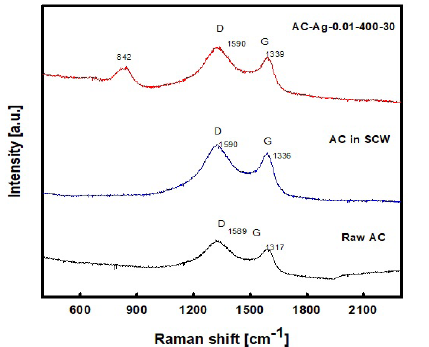
Fig. 4. Raman spectra of the primary activated carbon, activated carbon treated under SCW, AC-Ag